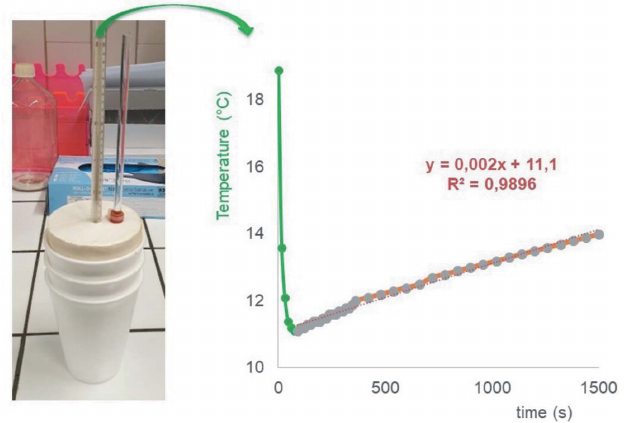
Figure 6 Determination of the heat of dissolution ( (cid:2) H diss ) of erythritol using a simple but effective calorimetry device. The evolution of the temperature of the erythritol solution over time makes it possible to estimate, by extrapolation, the value of the temperature change (cid:2) T and (cid:2) H diss . The endothermic nature of the dissolution of erythritol is clearly demon- strated by the rapid temperature drop of the solution.